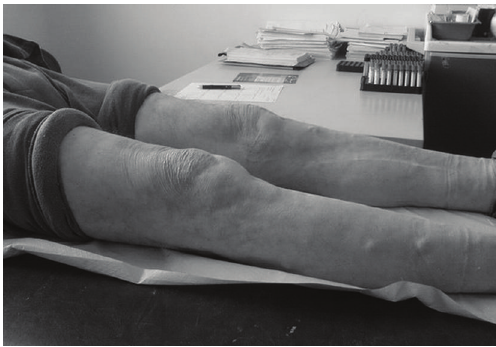
Figure 6: Full extension of both knees in 2-year